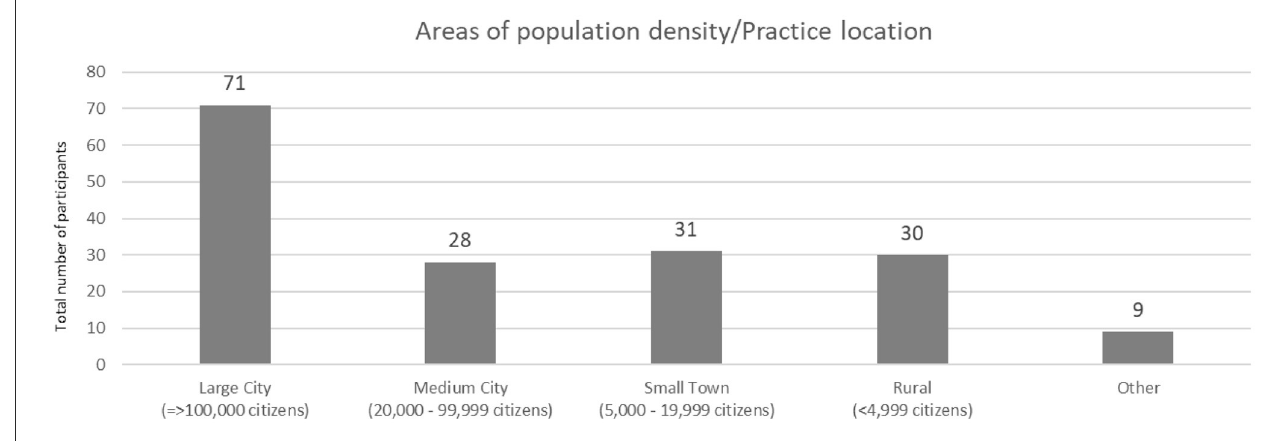
FIGURE1 Distribution of respondents in different areas of population density ( N = 169).